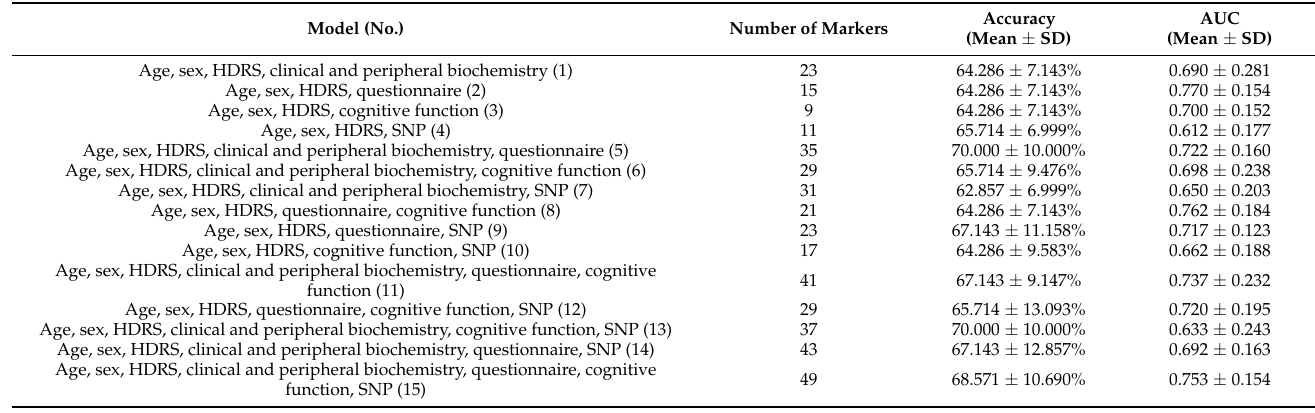
Clinical and peripheral biochemistry: including all variables in Table 1. Questionnaire: including all variables in Table 2. Cognitive function: including all variables in Table 3. SNP: single nucleotide polymorphism, including all variables in Table 4. Abbreviation: HDRS: 17-item Hamilton depression rating scale at baseline. AUC: the area under the receiver operating characteristic curve. SD: standard